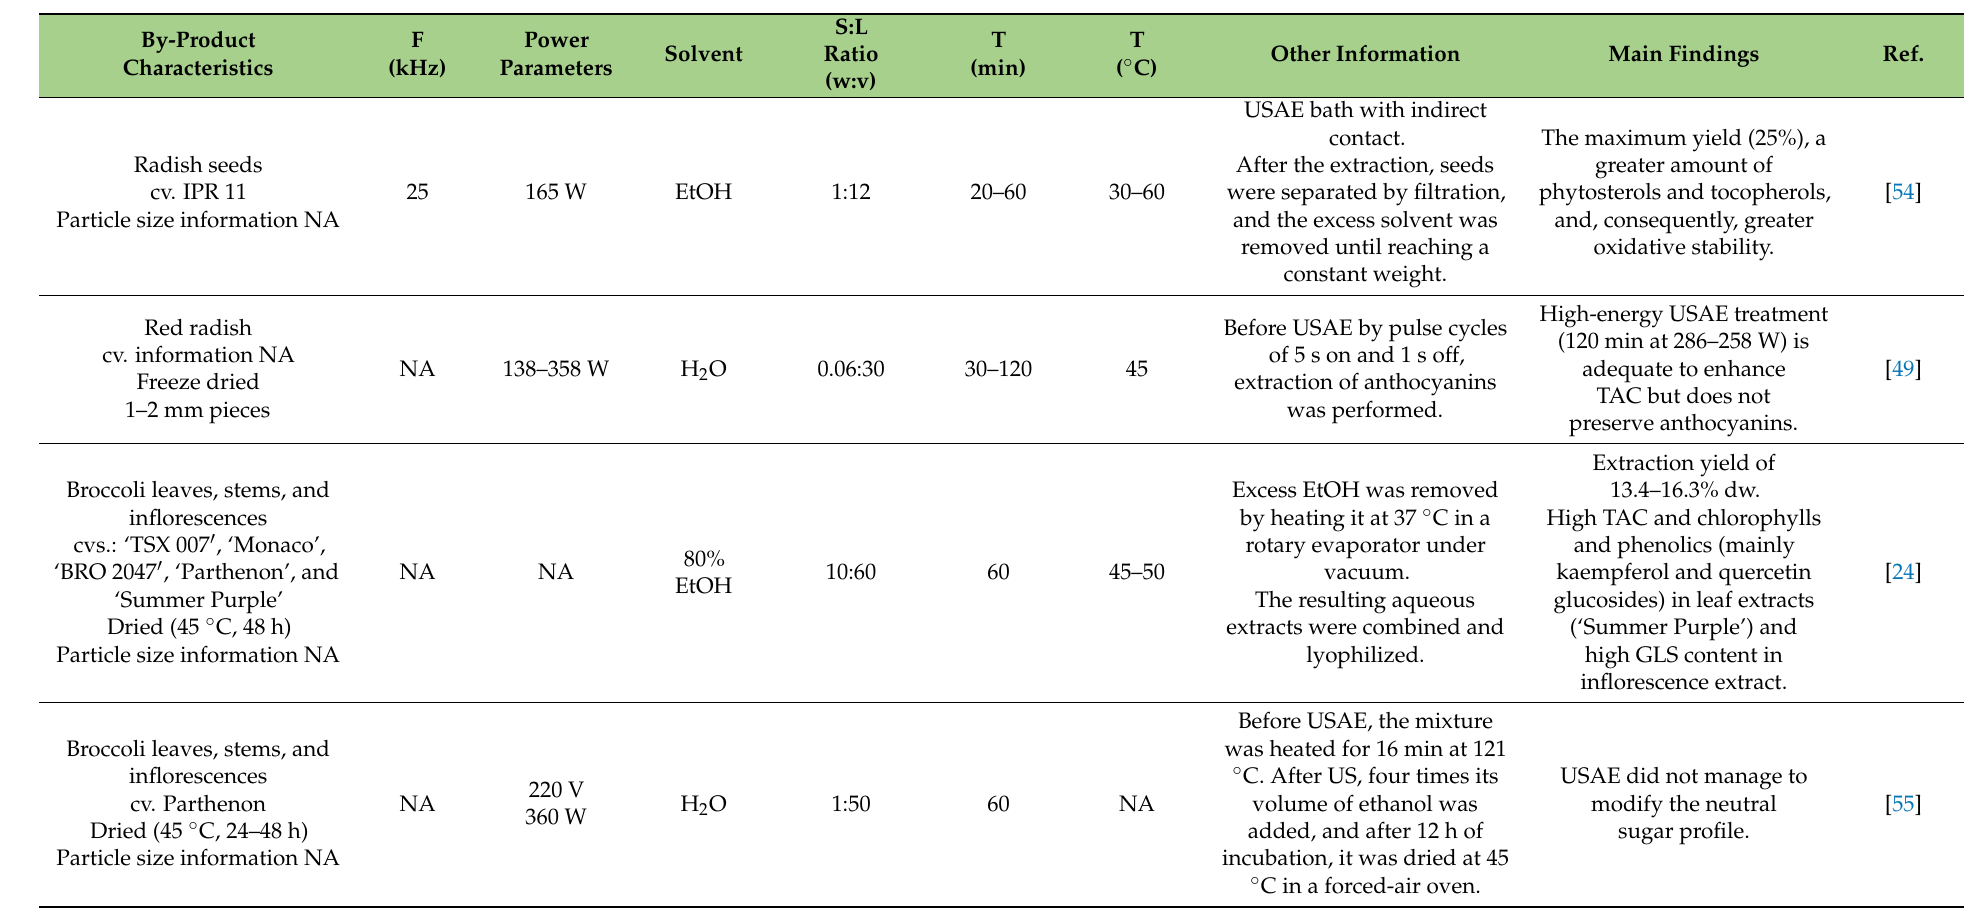
Table 1. Ultrasound conditions (frequency, power parameters, solvent, time, and temperature) for the extraction of bioactive compounds from Brassica